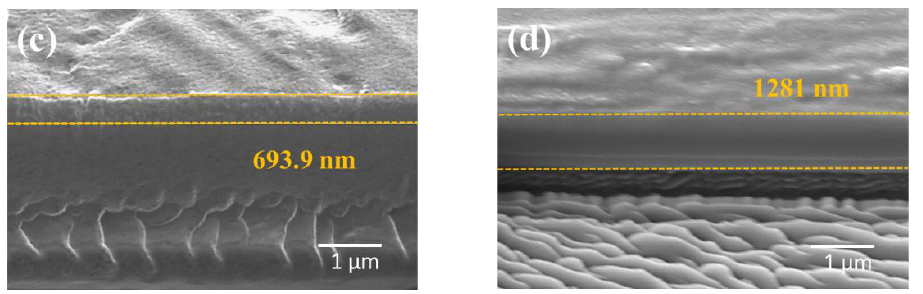
Figure 5. Cross-section SEM images of DLC film-coated titanium deposited at ( a ) CH4/H2 = 1:1, 6 h; ( b ) CH4/H2 = 1:1, 12 h; ( c ) CH4/H2 = 1:0, 6 h; ( d ) CH4/H2 = 1:0, 12 h.